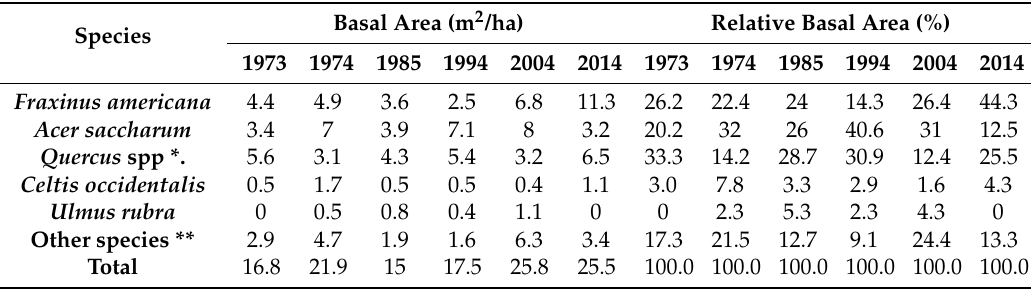
Table 2. Basal area (m 2 /ha) and Relative Basal Area for the dominant tree species in the canopy (DBH ≥ 30.0 cm) stratum at Dinsmore Woods recorded in the six sampling periods.